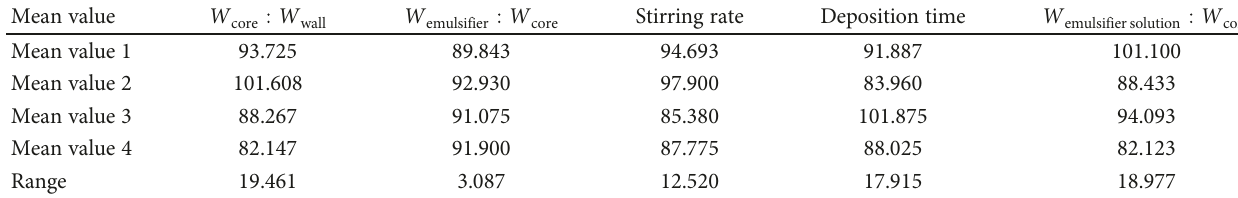
Table 10: Range of repair rates of microcapsules.